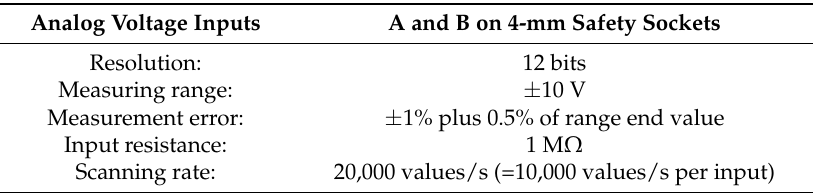
Table 5. Specifications of CassyLab